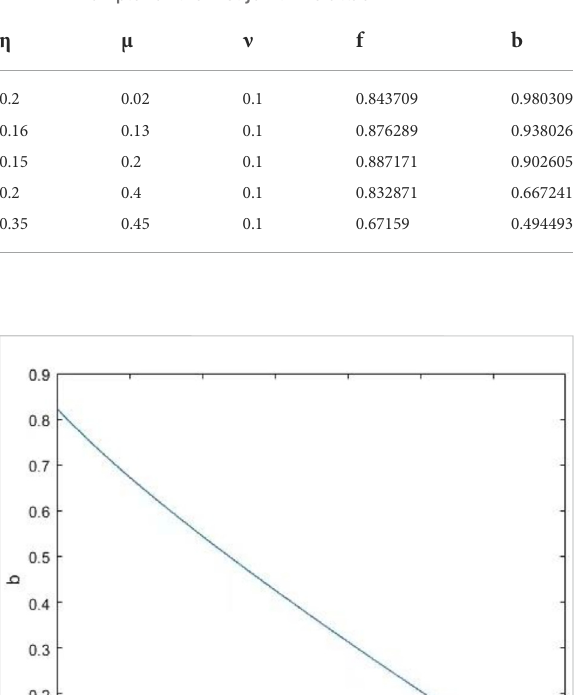
TABLE 1 Example for the fi rst joint PNS attack.